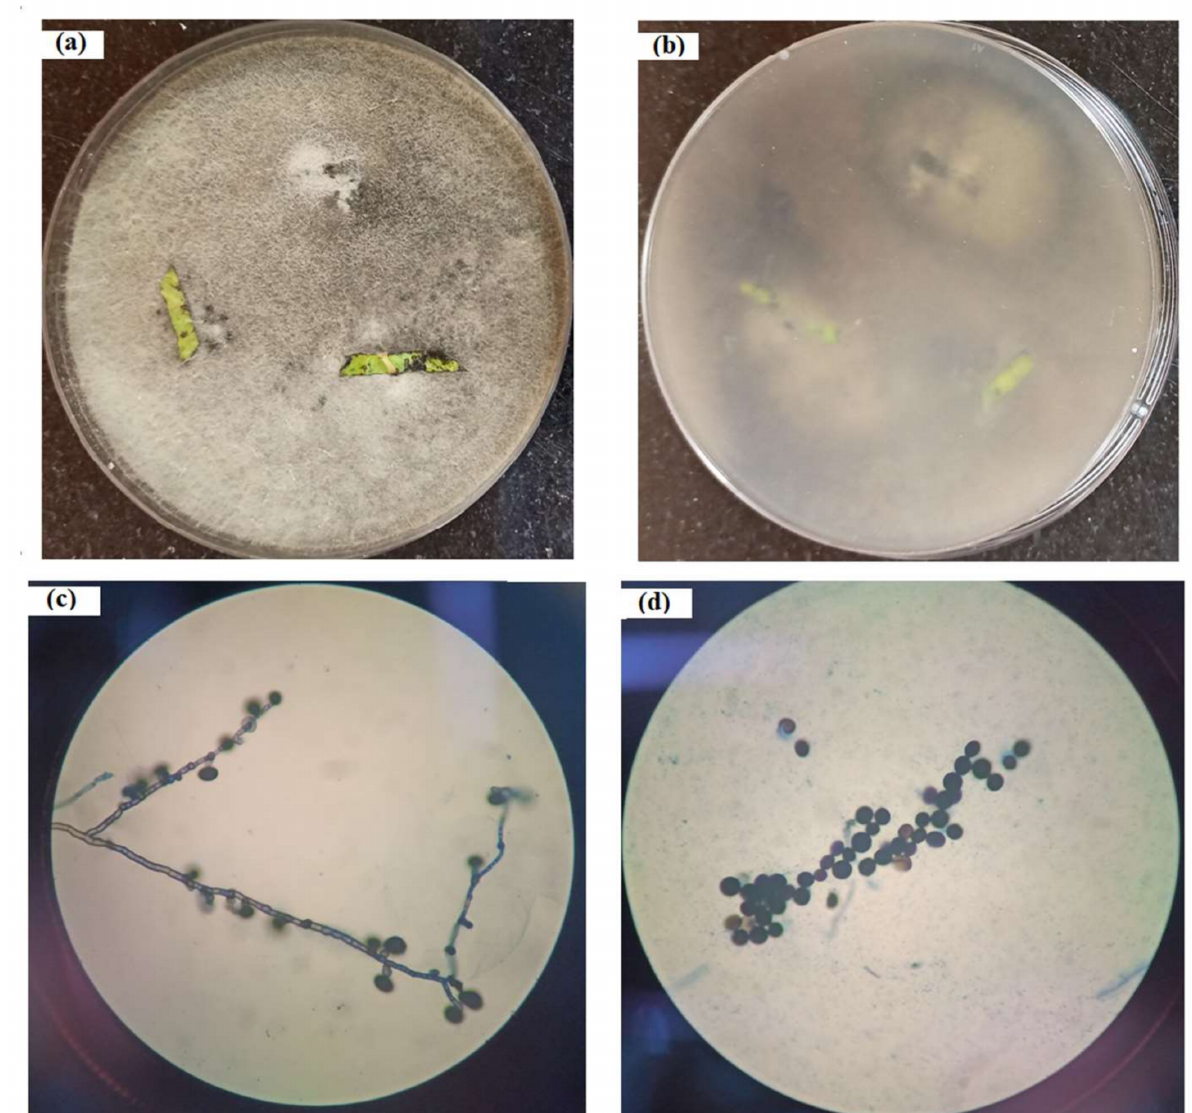
Figure 1. Isolated fungus Nigrospora zimmermanii on PDA media, showing ( a ) top view; ( b ) back view, microscopy of the isolated fungus Nigrospora zimmermanii ; ( c ) hypha with conidiophores; ( d )